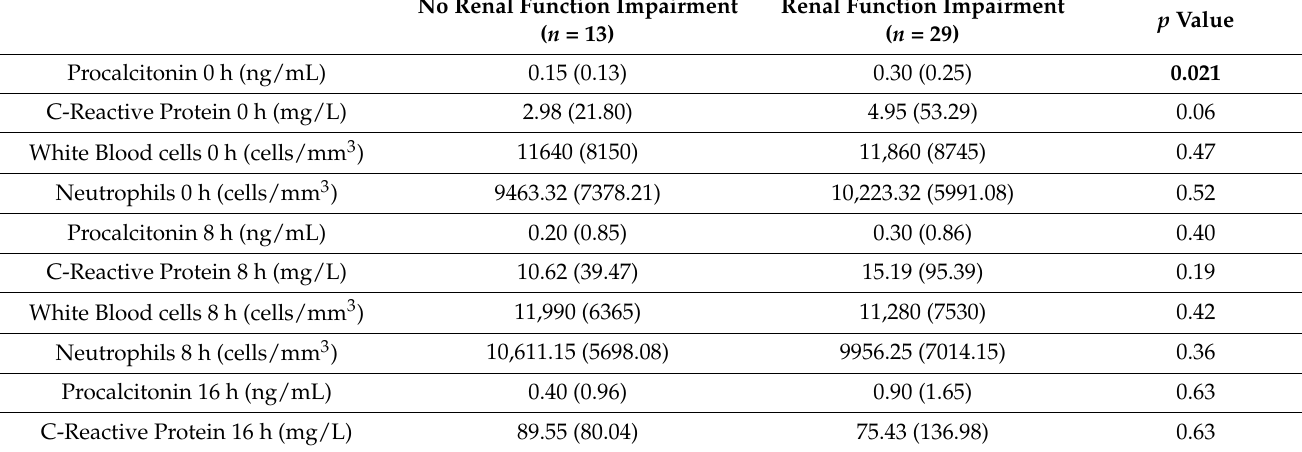
Table 2. Biomarker levels based on the presence/absence of renal function impairment over time in patients with lung infection. Biomarkers are represented as median and interquartile range (IQR). p values < 0.05 are highlighted in